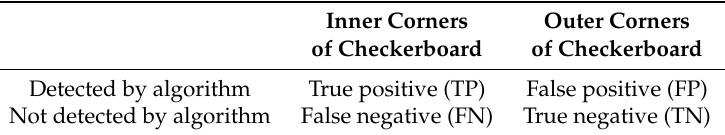
Table 1. Confusion matrix for evaluation of automated calibration algorithm.